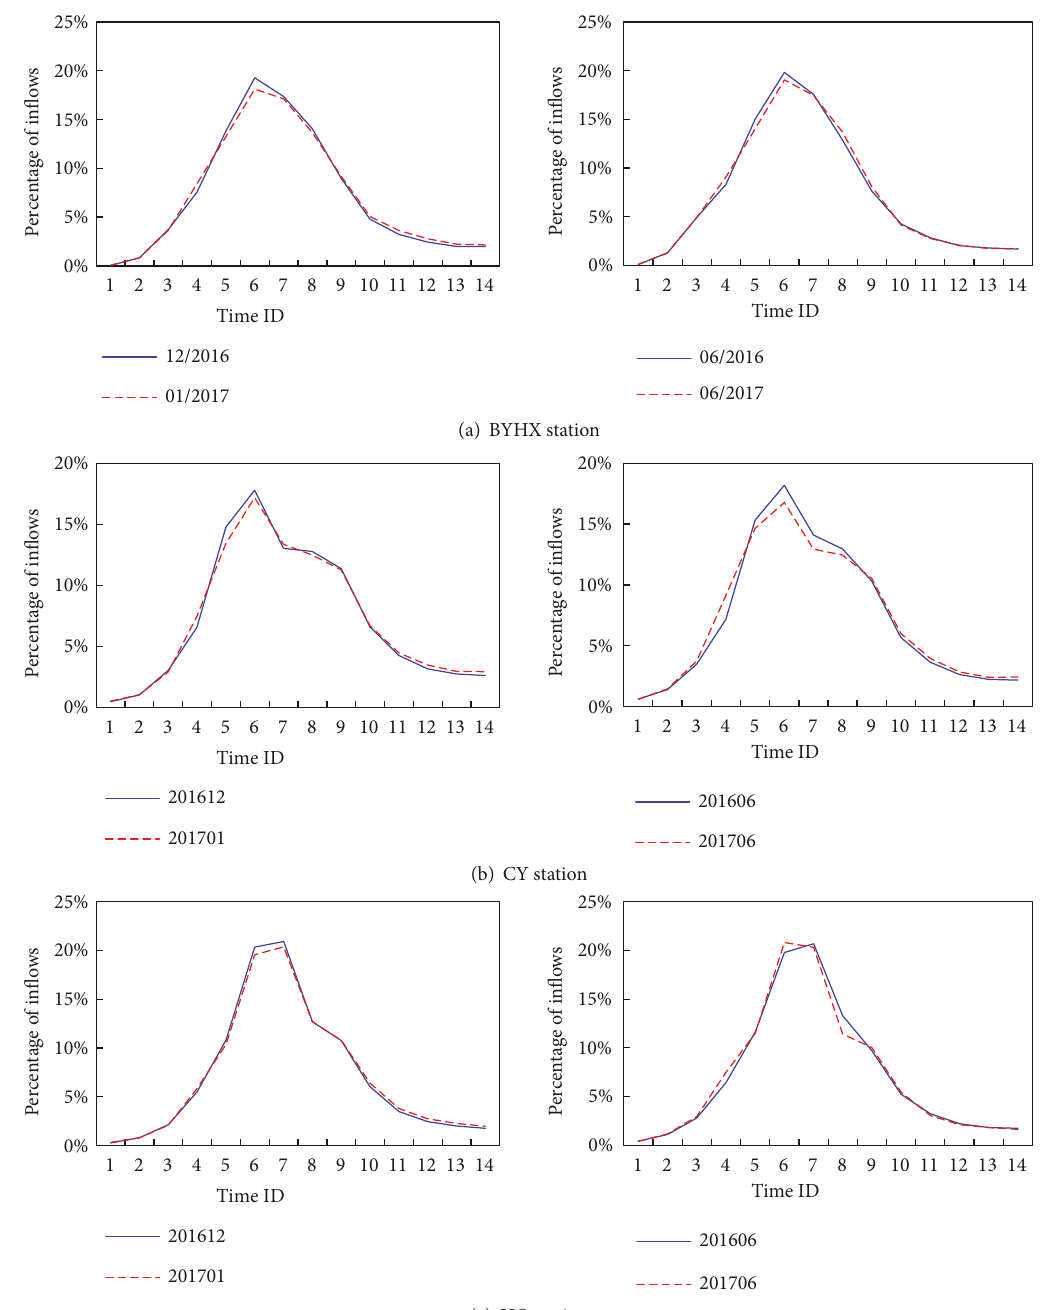
Figure 2: Demand distributions of stations before and after the fare